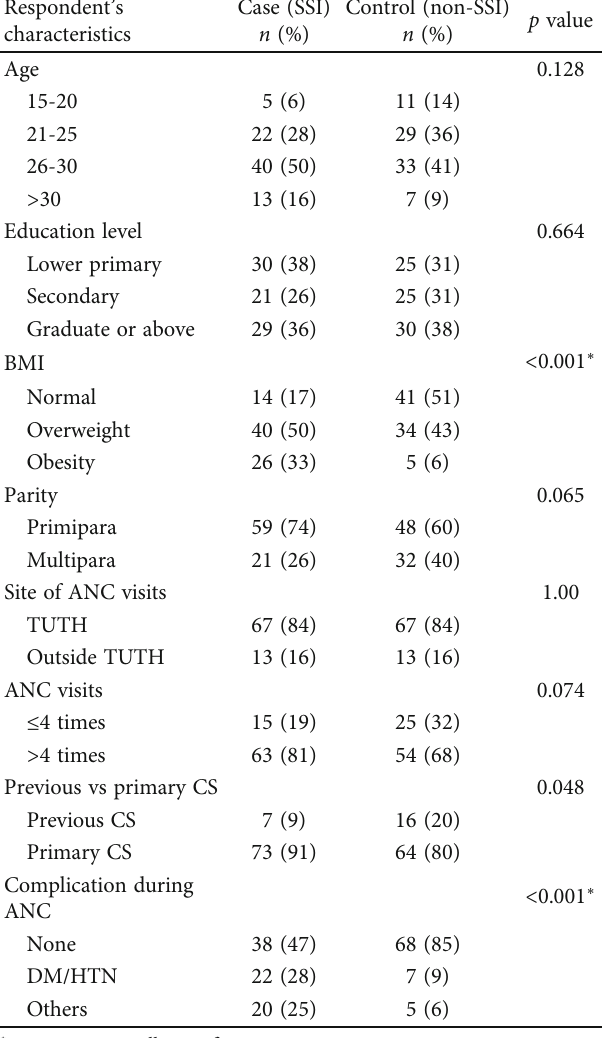
Table 1: Host-related characteristics of patients with SSI following cesarean section compared with control